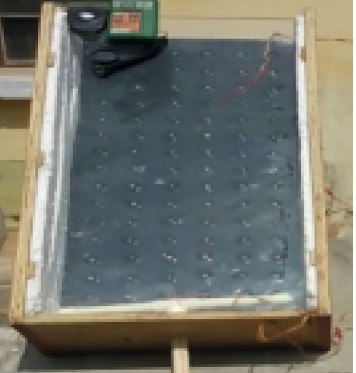
Figure 5: Photographic view of the solar